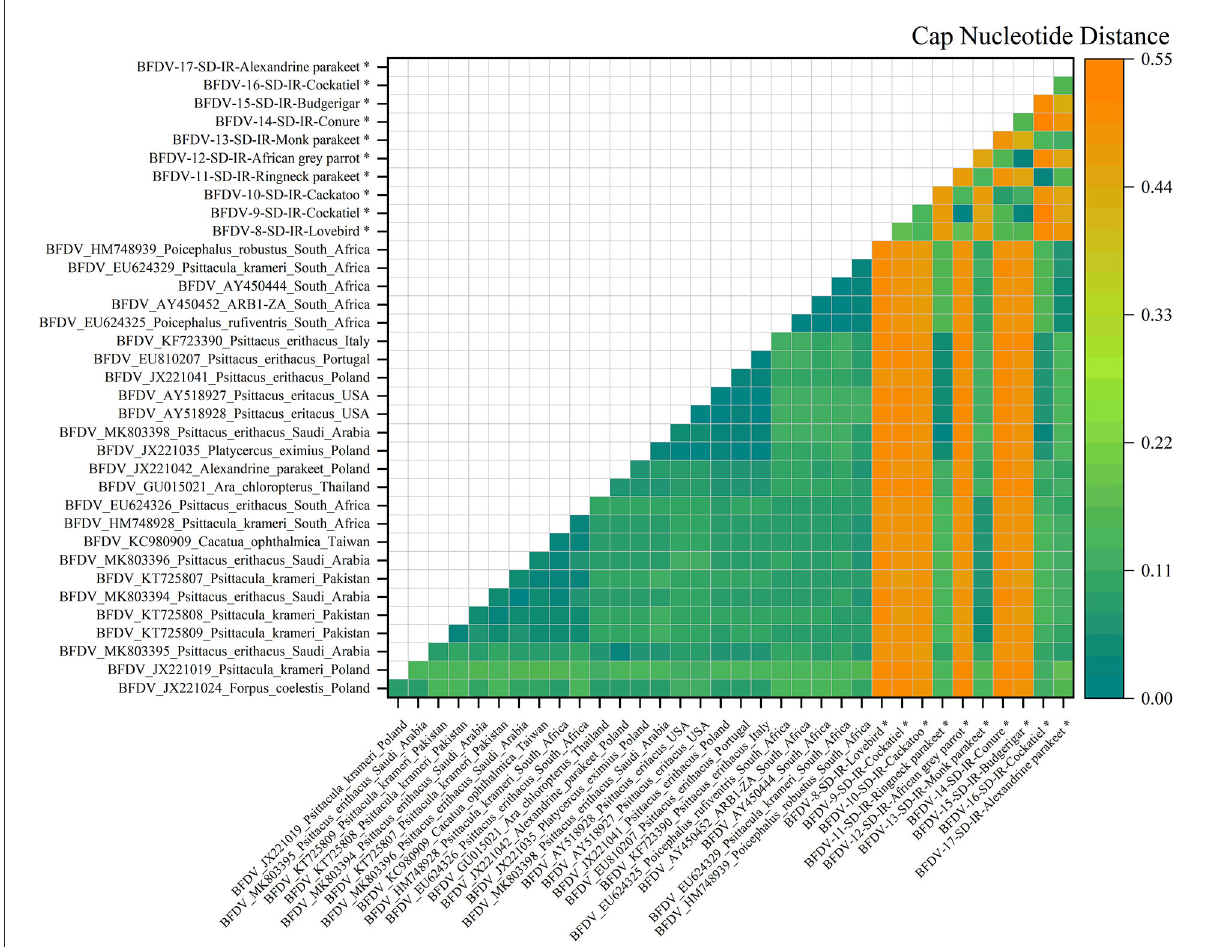
FIGURE6 An illustration of the pairwise distance between cap nucleotide sequences based on the pairwise deletion of gaps in all ten cap sequenced sequences and 26 PubMed sequences. The labels represent the sequence information within GenBank with year of sample collections, GenBank accession number, the name of bird, and the country of host. All cap sequences of this study are marked with a black star